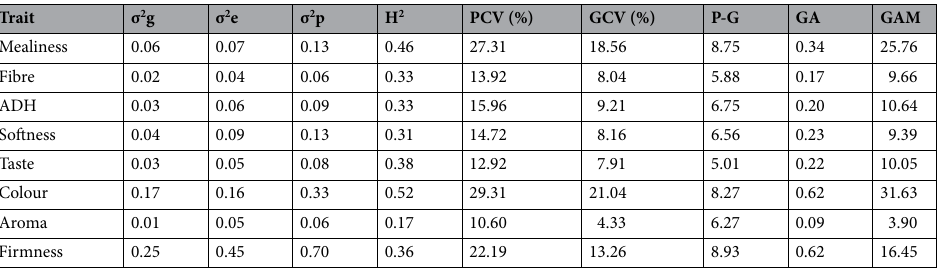
Table 3. Estimates of variance components, broad sense heritability, PCV, GCV, and genetic advance for eight traits in 150 cassava genotypes evaluated in three environments in Nigeria. ADH, Adhesiveness; σ 2 g , Genotypic variance; σ 2 e , Residual variance; σ 2 p , Phenotypic variance; H 2 , Broad sense heritability; PCV, Phenotypic coefficient of variation; GCV, Genotypic coefficient of variation; GA, Genetic advance; GAM, Genetic advance as a percentage of